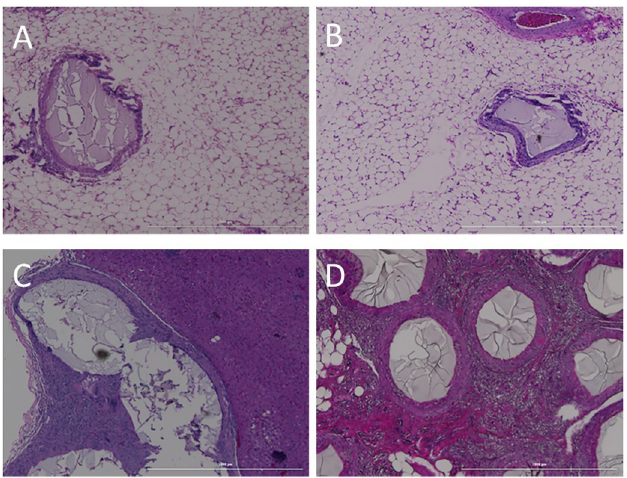
Fig 7. Histology of transplant sites int diabetic dogs. A & B) In diabetic dogs with longer time points (58–65 days) any indication of a foreign body response in the omentum was classified as mild with incomplete fibrotic rings. C) However when a few microspheres attached to the liver, granulomatous inflammation and fibrosis were noted. D) Microspheres within the omentum, but clustered together, also elicited a stronger foreign body response than individual microspheres. All scale bars = 1000 μ